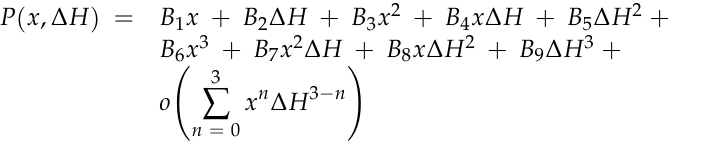
Figure 13. Plate thickness affects torsional vibration .